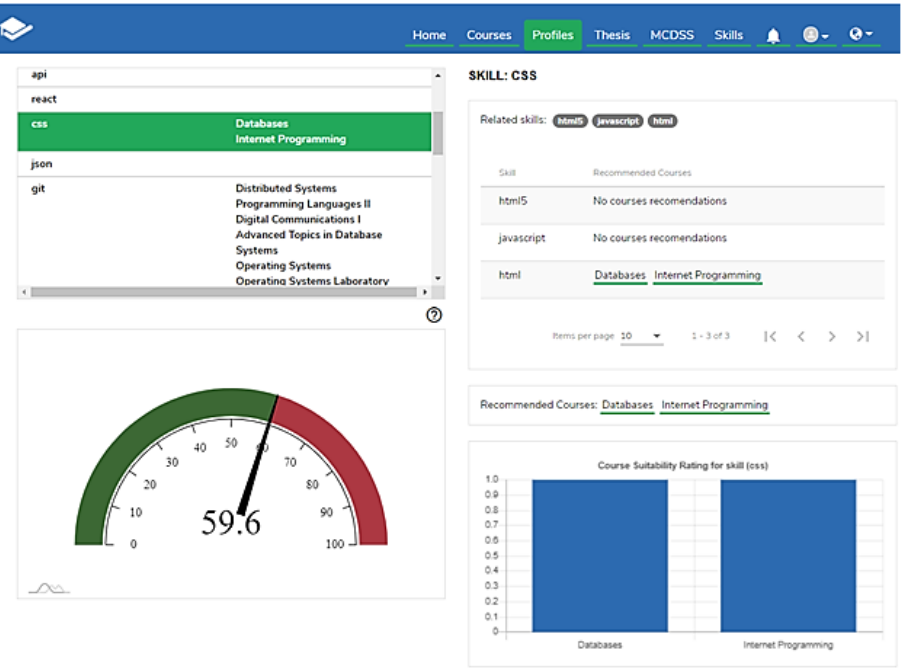
Figure 9. Curriculum Designer analytics page, emphasizing CSS skill.